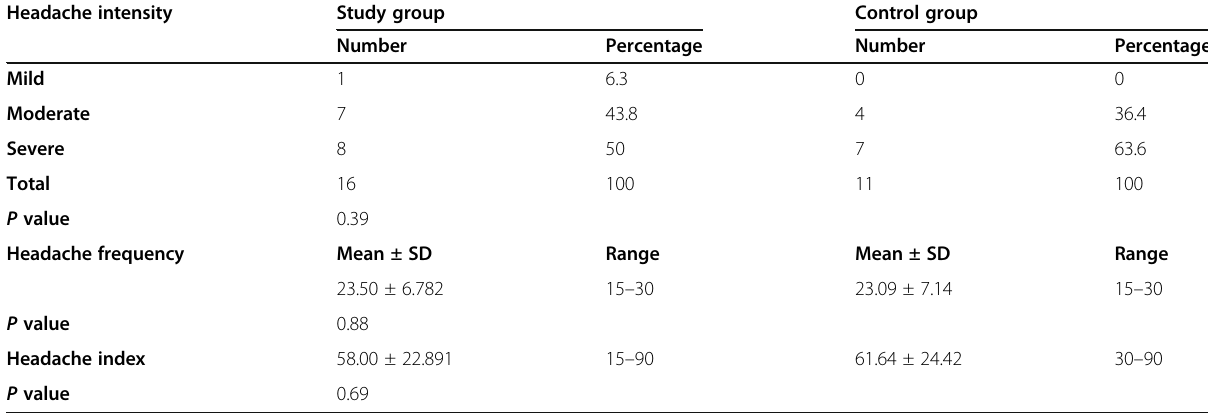
Table 1 Comparison of pre-treatment headache parameters between study and control groups Headache intensity